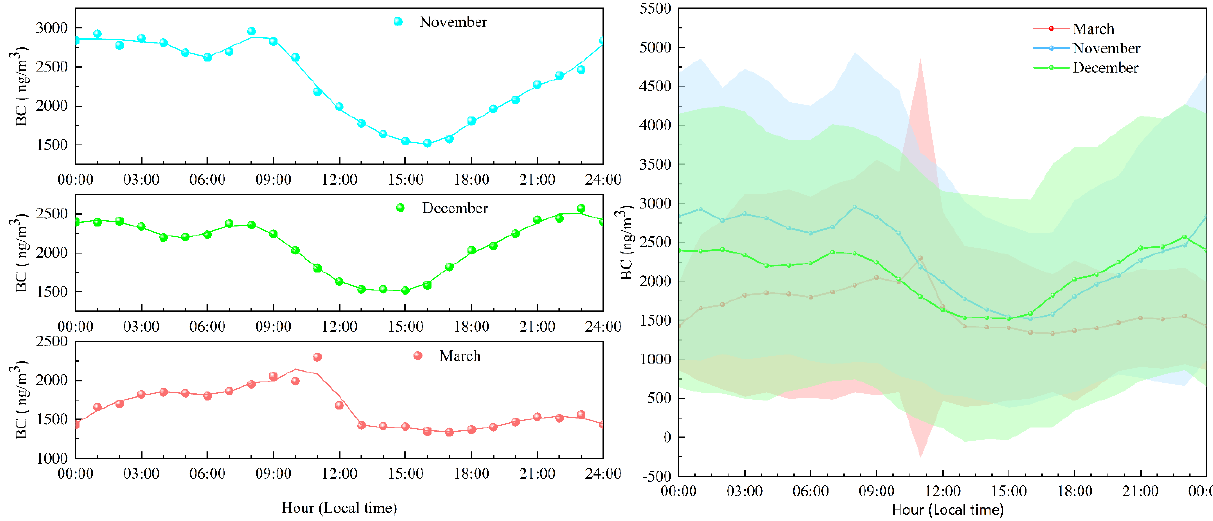
Figure 4. Diurnal variation in BC concentration during observations.